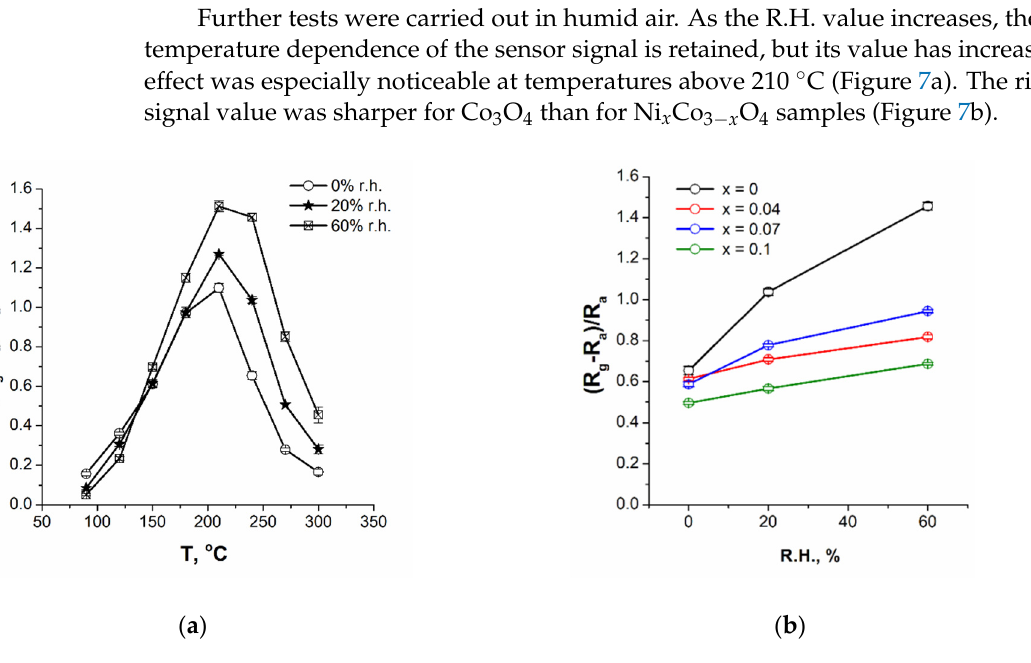
Figure 7. ( a ) The temperature dependence of the sensor signal of Co 3 O 4 at the range of 90–300 ◦ C in the presence of H 2 S (1 ppm) at different air humidity (0, 20, 60% R.H.); ( b ) Dependence of the sensor signal of Co 3 O 4 and Ni x Co 3 − x O 4 on air humidity at 240 ◦ C toward 1 ppm H 2 S.